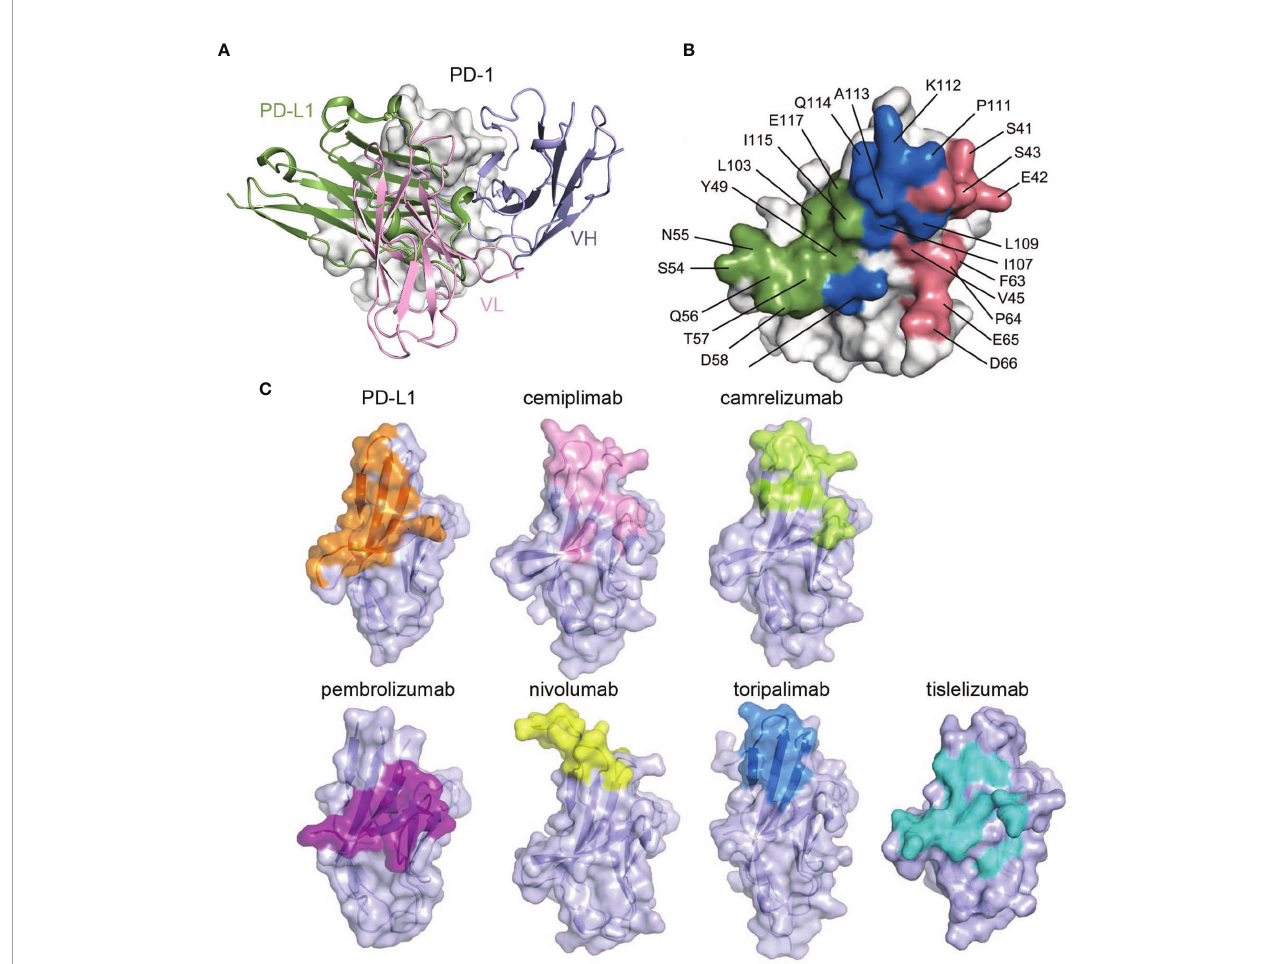
FIGURE 3 | Structural basis of the blockade binding of cemiplimab with PD-L1. (A) Comparison of cemiplimab/PD-1 with PD-L1 extracted from PD-1/PD-L1 complex structure (PDB code: 4ZQK). PD-L1 is shown as smudge cartoon, while PD-1 is shown as surface diagram in white. VH and VL of cemiplimab-scFv are shown as cartoons in light blue and light pink, respectively. (B) The competitive binding surfaces of cemiplimab with PD-L1 on PD-1. The residues bound to cemiplimab alone are colored in deep salmon, while the residues contact with PD-L1 alone are colored in smudge, and the residues contacted by both cemiplimab and PD-L1 are colored in blue. The epitope residues in PD-1 are pointed out in black characters. (C) The binding surface of PD-L1 and structurally known clinically approved MAbs on PD-1 is shown in different colors. The binding surface of PD-L1 and other MAbs, e.g., cemiplimab, camrelizumab, pembrolizumab, nivolumab, toripalimab, and tislelizumab are colored in orange, light pink, limon, purple, yellow, blue, and teal,